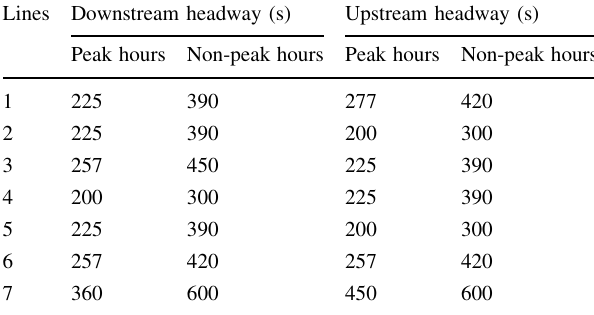
3.49 and 4.16 during peak and non-peak hours, respec-